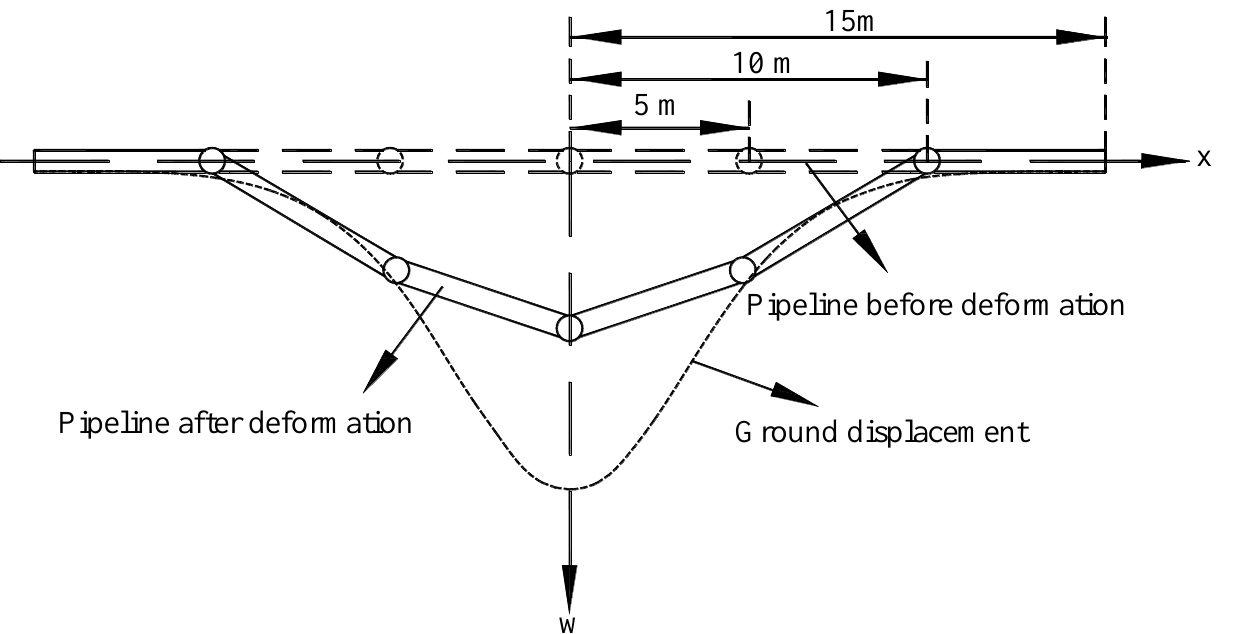
Figure 11. Example of buried jointed unilateral pipeline.